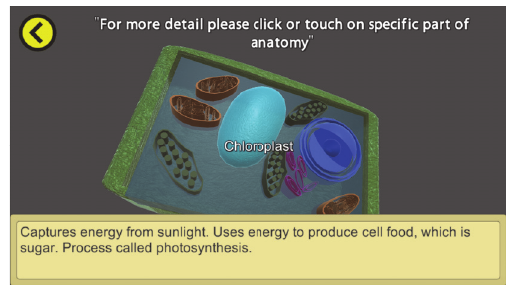
Figure 23: Cell-anatomy scene.